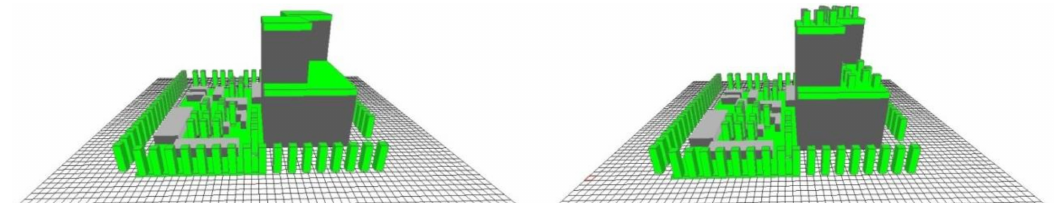
Figure 7. 2013 3D morphology of grass-planted roof (left) and 2013 3D morphology of grass-/tree- planted roof (right) in